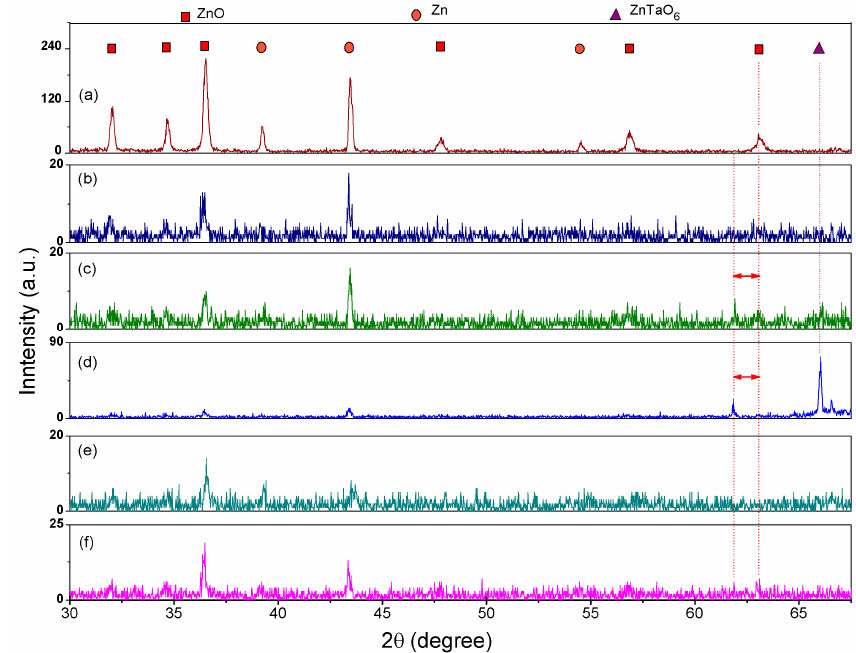
Figure 4. Patterns for ( a ) undoped ZnO film, and ZnO:Ta-doped films grown with a pellet weight of